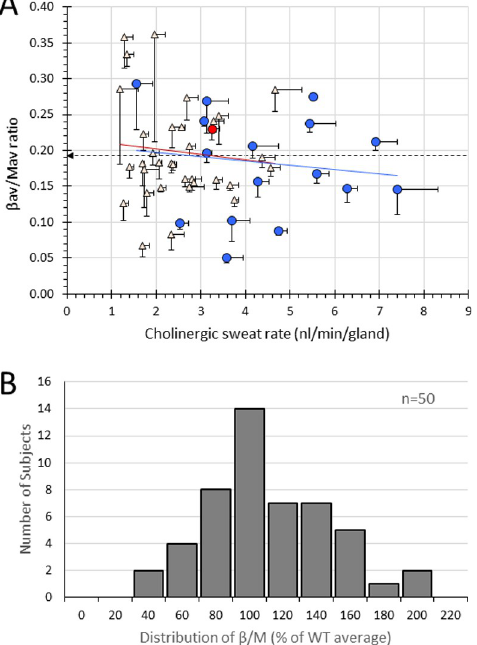
Fig 3. Consistent differences in β -sweating across subjects. A . Distribution of average β -sweat rate to the average cholinergic sweat rate for 50 subjects. SEMs are shown in one direction for clarity. Except as noted, each point represents averages from 3 tests per subject and corresponds to the star in Fig 2 . For each of the three tests an average of 60 ± 19 identified glands were measured. Regression did not differ significantly from zero (r = 0.15, n = 50, p = 0.30) or for sexes considered separately (shown as red and blue lines). Dark dashed arrow indicates the overall β /M average for all 50 subjects; lighter dashed arrows are ± one SD. Pink triangles are female subjects and blue circles are males. Red circle is mean data for subject 38 and corresponds to the star in Fig 2 . One subject has only two tests and two subjects had only a single test (see Table 1 ). B . Each point was normalized to the mean set to 100%, and the distribution